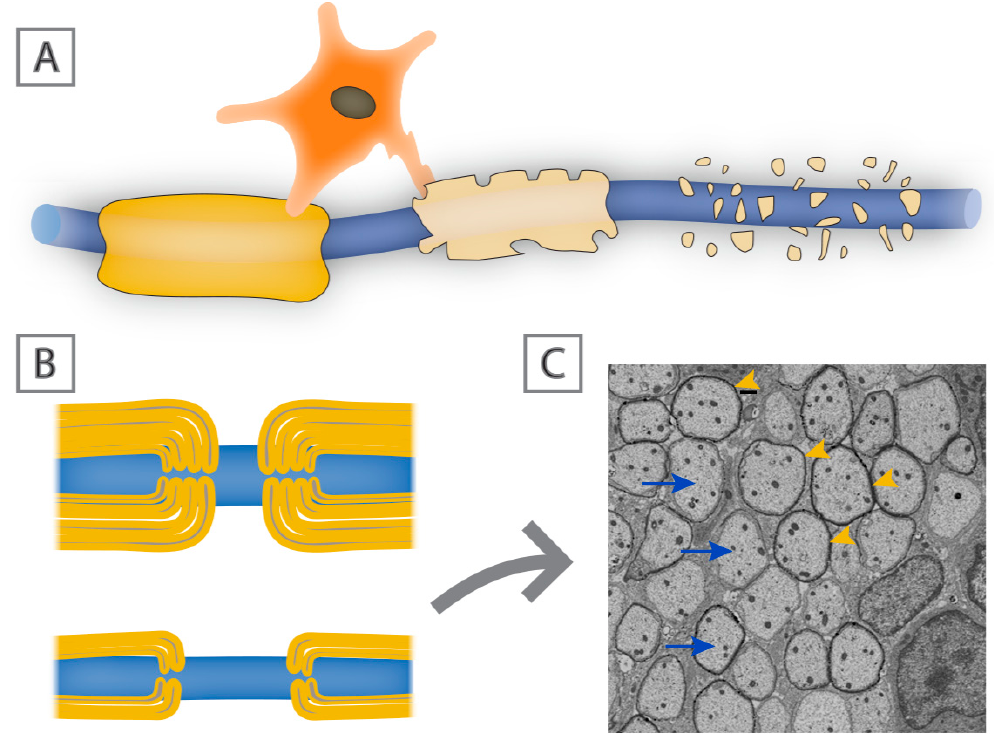
Figure 3. Demyelination vs. remyelination. Schematic of a myelinated axon ( A ), in which there is oligodendrocyte dysfunction and subsequent loss of myelin sheaths. Remyelinated axons (( B ); lower panel) are characterized by thin myelin sheaths. ( C ) Electron micrograph of axons (arrows) in the dorsal white matter of the spinal cord in an adult rat showing thin myelin sheaths (arrowheads) following lysolecithin-induced demyelination.